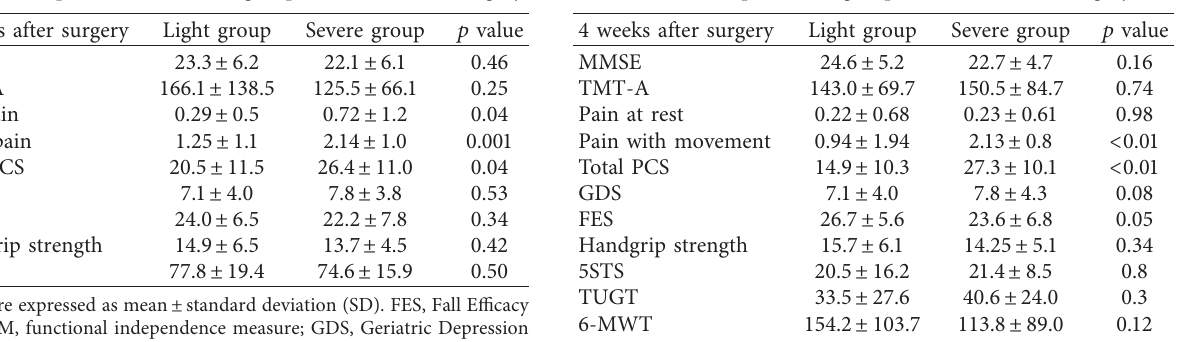
Table 2: Comparison between the groups at 2 weeks after surgery. Table 3: Comparison of groups at 4 weeks after